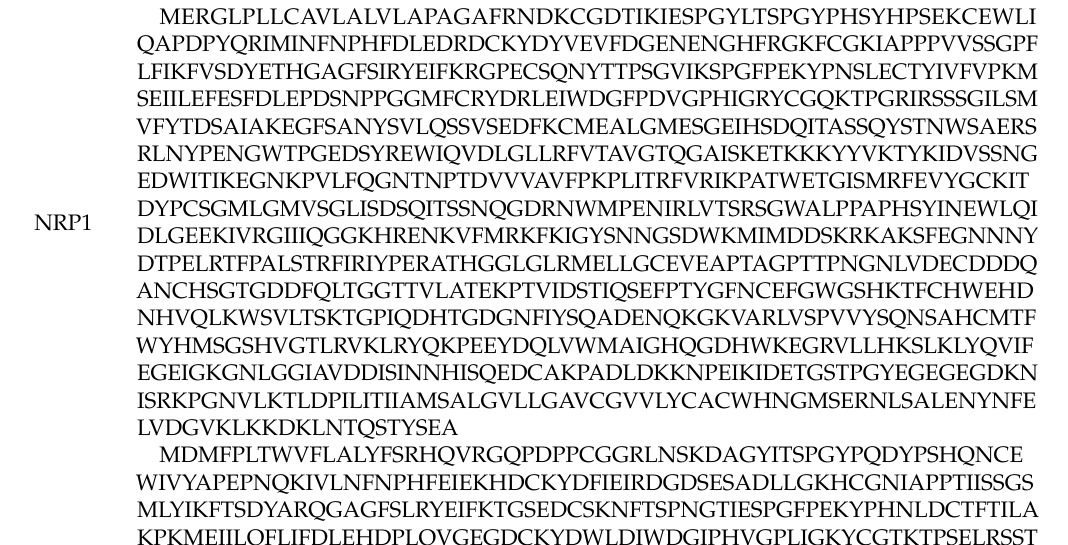
Table 2. NRP1 and NRP2 primary amino acid sequences. Primary amino acid sequences used to search for templates to build models for NRP1 and NRP2